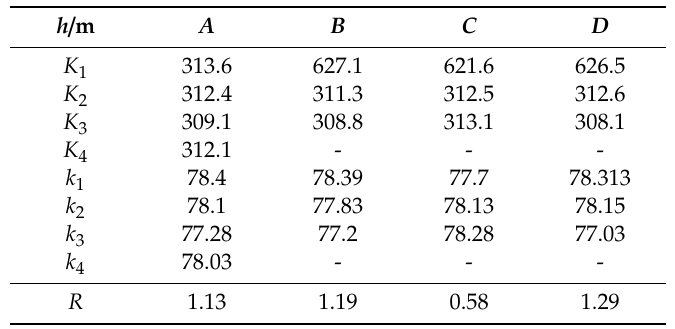
Table 12. 1.0 Q e ffi ciency analysis.